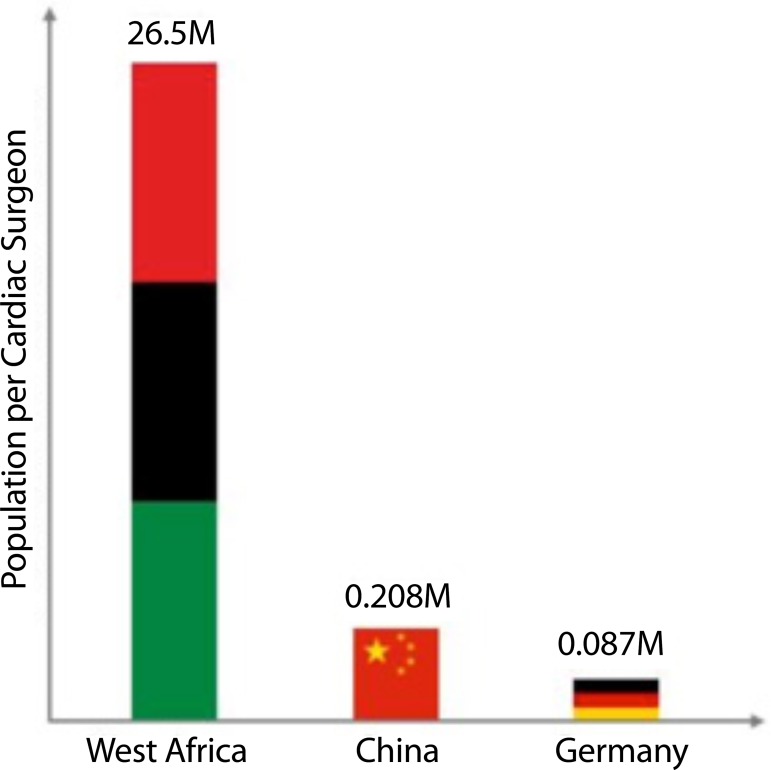
Population in million per cardiac surgeon[2].